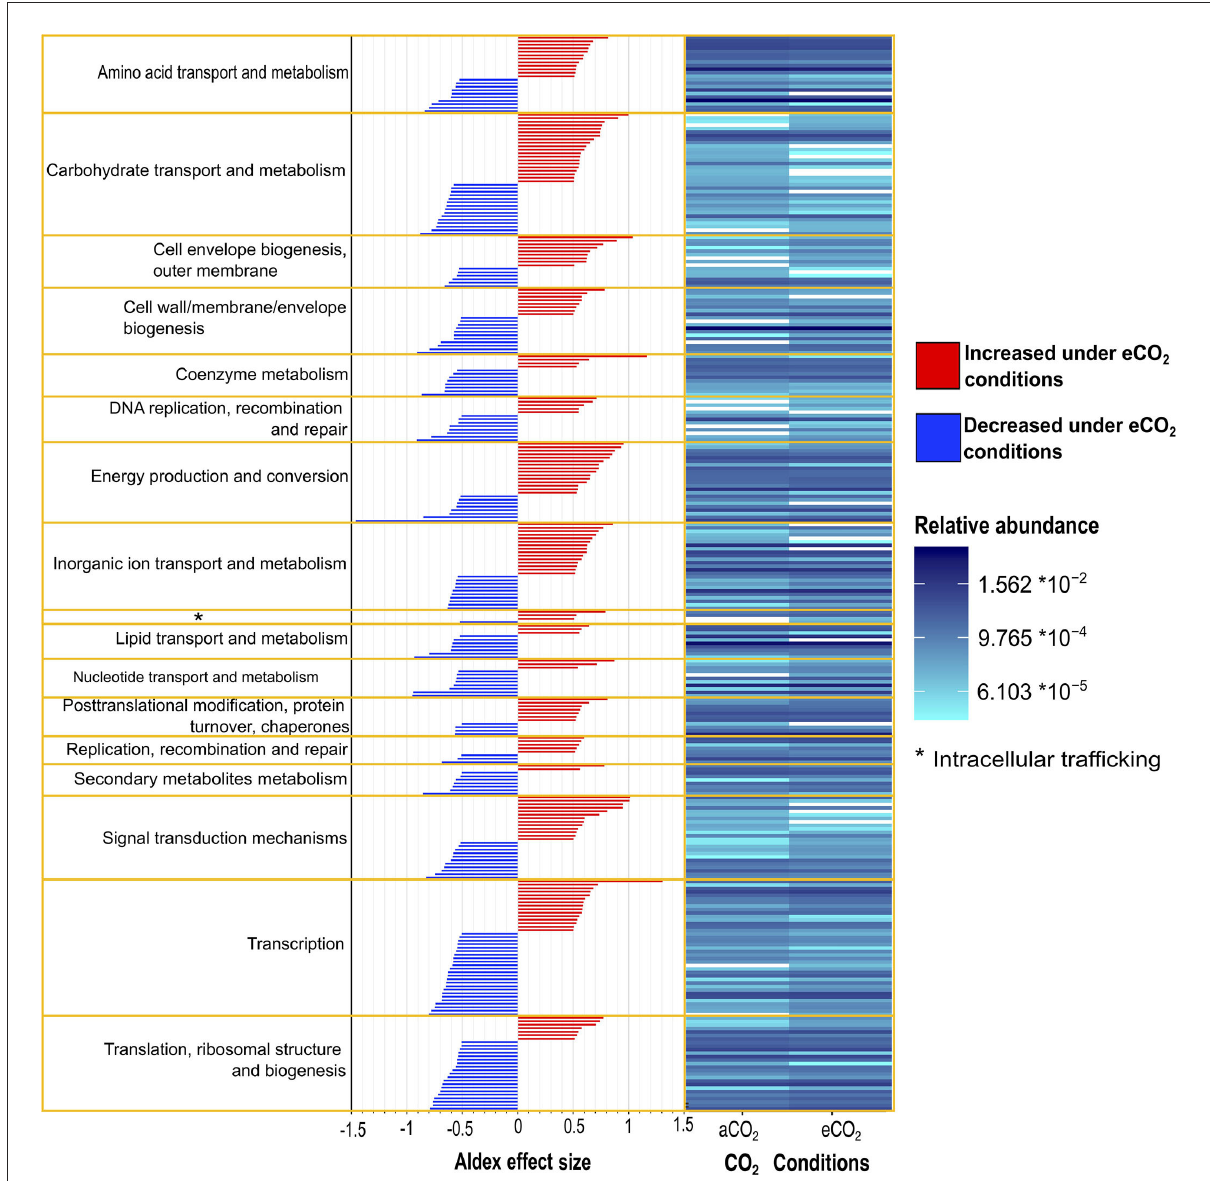
FIGURE3 Differential abundance of Gi-FACE metatranscriptome core transcripts annotated against GenBank Clusters of Orthologous Groups (COG) and grouped according to COG categories. Results expressed as relative abundance (right) and ALDEx2 effect size (left) of transcripts with